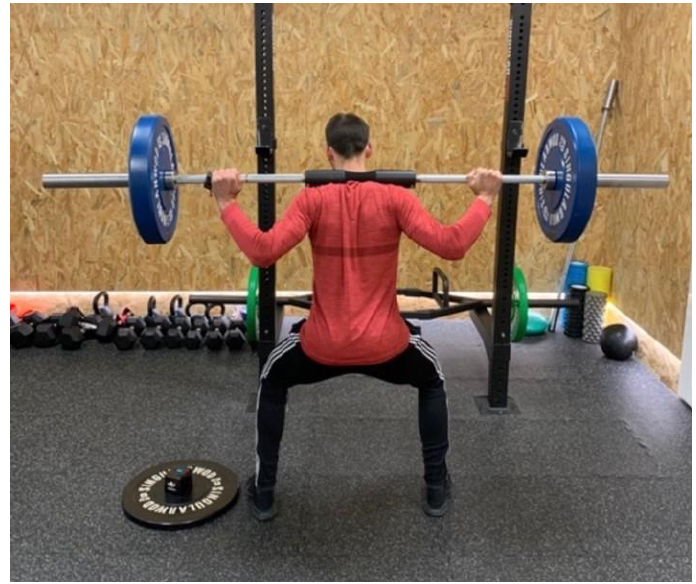
Figure 3. Squat performance speed assessment.